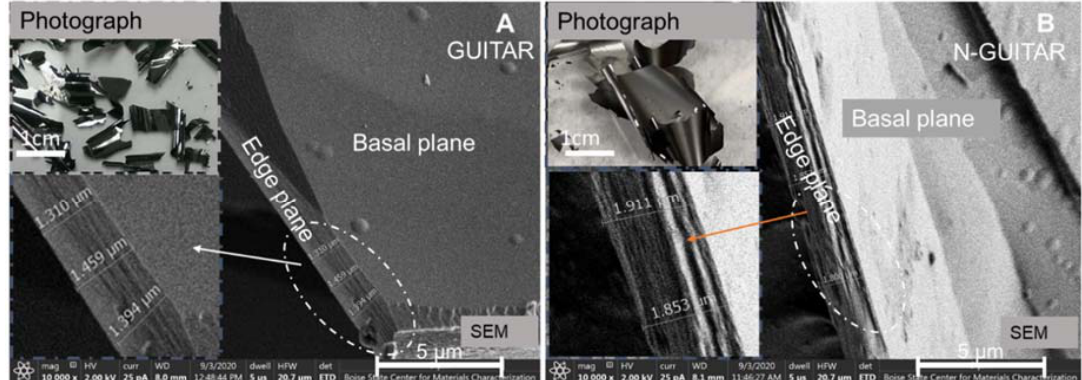
Figure 3. Scanning electron micrographs (SEM) of GUITAR ( A ) and N ‐ GUITAR ( B ) with photographs of the flakes in the upper left insets. Both materials exhibit layered morphologies with edge and basal planes. The lower left insets show the SEM’s of edge planes in more detail.